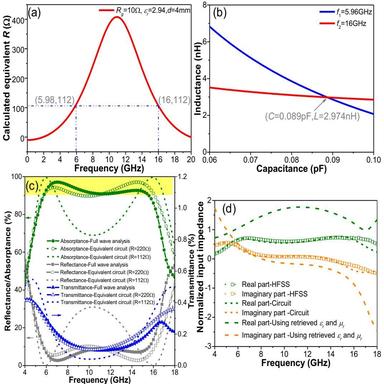
(a) R-f spectrum and (b) L-C relation curves at 5.98 GHz and 16 GHz with εr = 2.94, d = 4 mm and Rg = 10 Ω. (c) Simulated absorptance (green), reflectance (gray) and transmittance (blue) of the WMA from full wave analysis (solid dots line) and from its equivalent circuit model with calculated R = 112 Ω (dash line) and optimized R = 220 Ω (hollow dots line). (d) normalized input impedance zin spectra obtained from HFSS (square-dot line), equivalent circuit model (dash line), and retrieved εr and μr (dash-dot